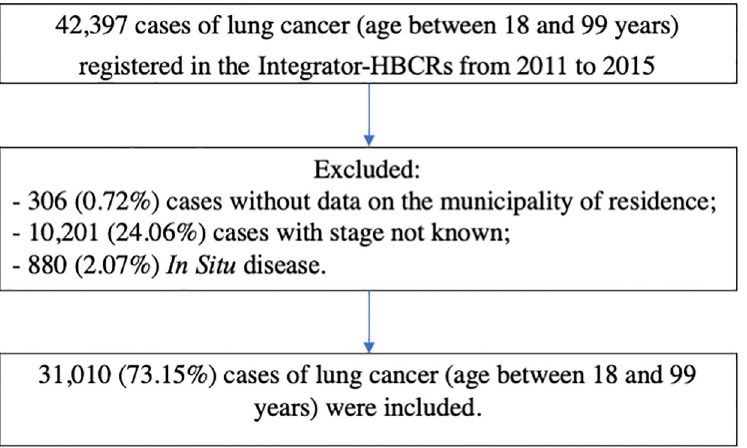
Fig 1. Flowchart of the selection procedure of lung cancer cases between 2011 and 2015 in the Integrator-HBCRs.